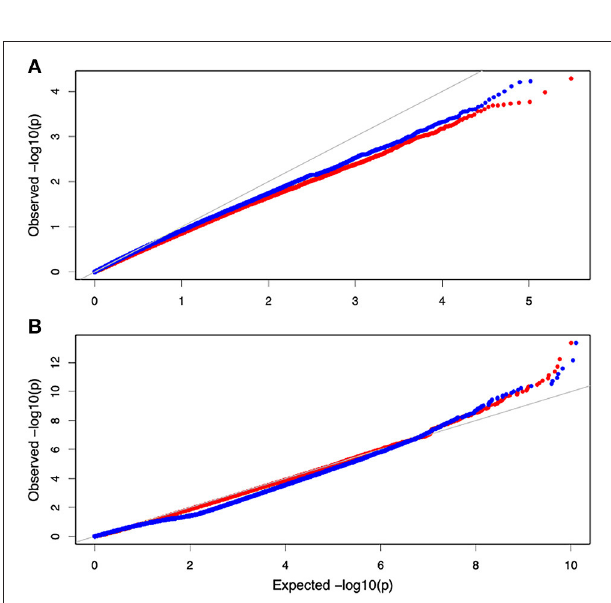
FIGURE 5 | QQ plot of the gene association analysis results. (A) QQ plot derived from the genome-wide multivariate association mixed model (GMA) results. (B) Distribution of p values derived from the functional mapping